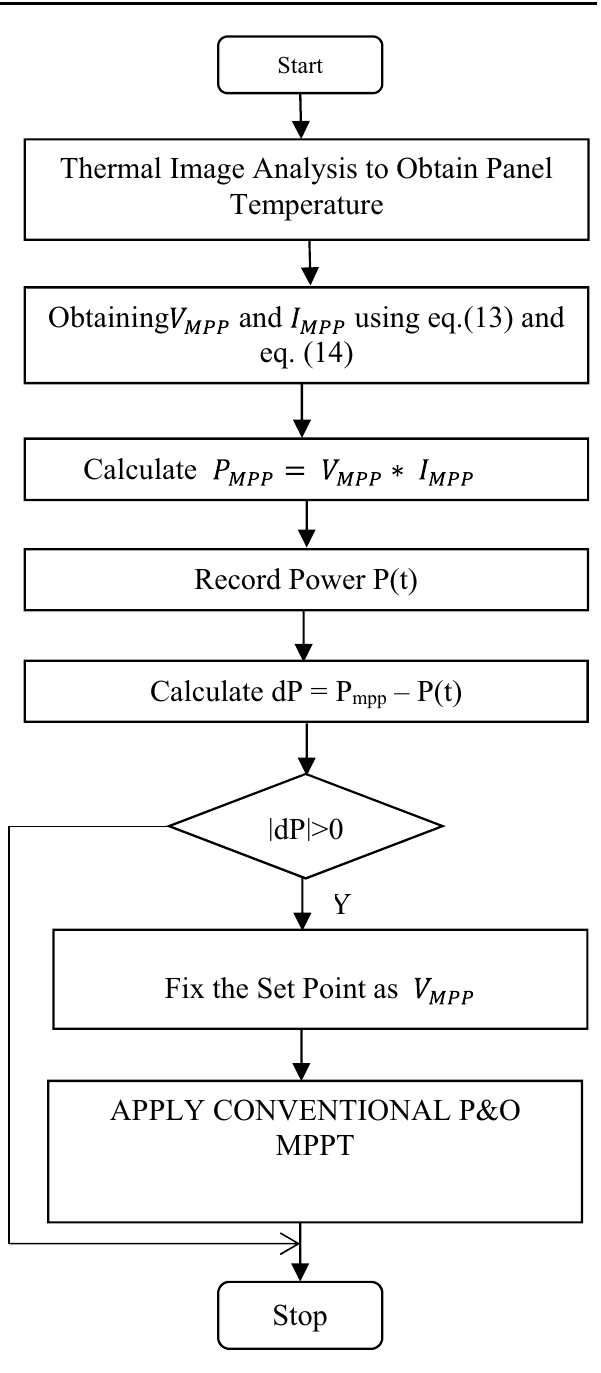
Fig. 3 Flow graph of thermography based MPPT